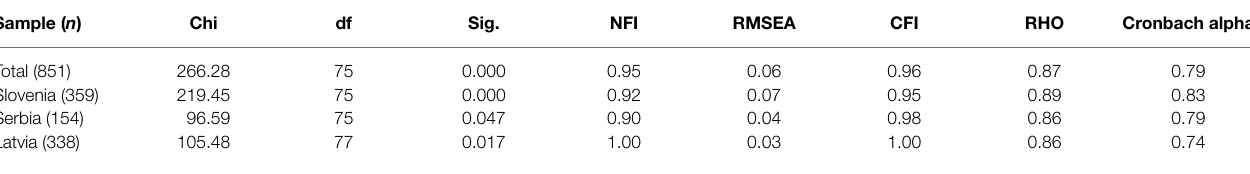
TABLE 7 | Structural equation modeling results (goodness-of-fit and reliability).